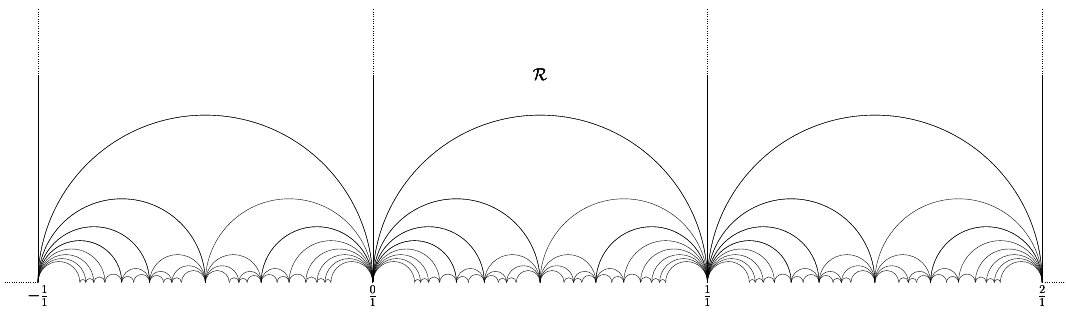
Figure 1. Lines of marginal stability in the axion-dilaton complex upper half plane for the case N = 1